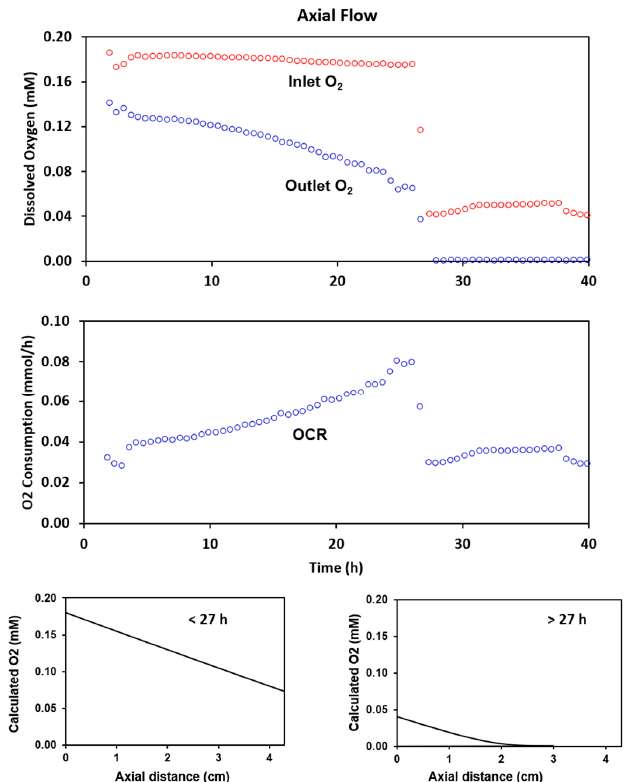
Figure 3. Measured perfusate oxygen levels during growth with axial flow perfusion . Cells were grown on microcarriers for 40 h (top). As the cell number increased over the first 27 h, the oxygen consumption rate (OCR) increased to 0.08 mmol/h and the oxygen concentration in the outlet medium declined to approximately 0.07 mM (middle). When the inlet oxygen concentration was reduced from approximately 0.18 mM to 0.04 mM, the cell mass became oxygen limited and the oxygen consumption rate dropped to 0.04 mmol/h. Calculated oxygen profiles for inlet oxygen levels of 0.18 mM and 0.04 mM confirm that oxygen is limiting at the lower oxygen concentration (bottom).